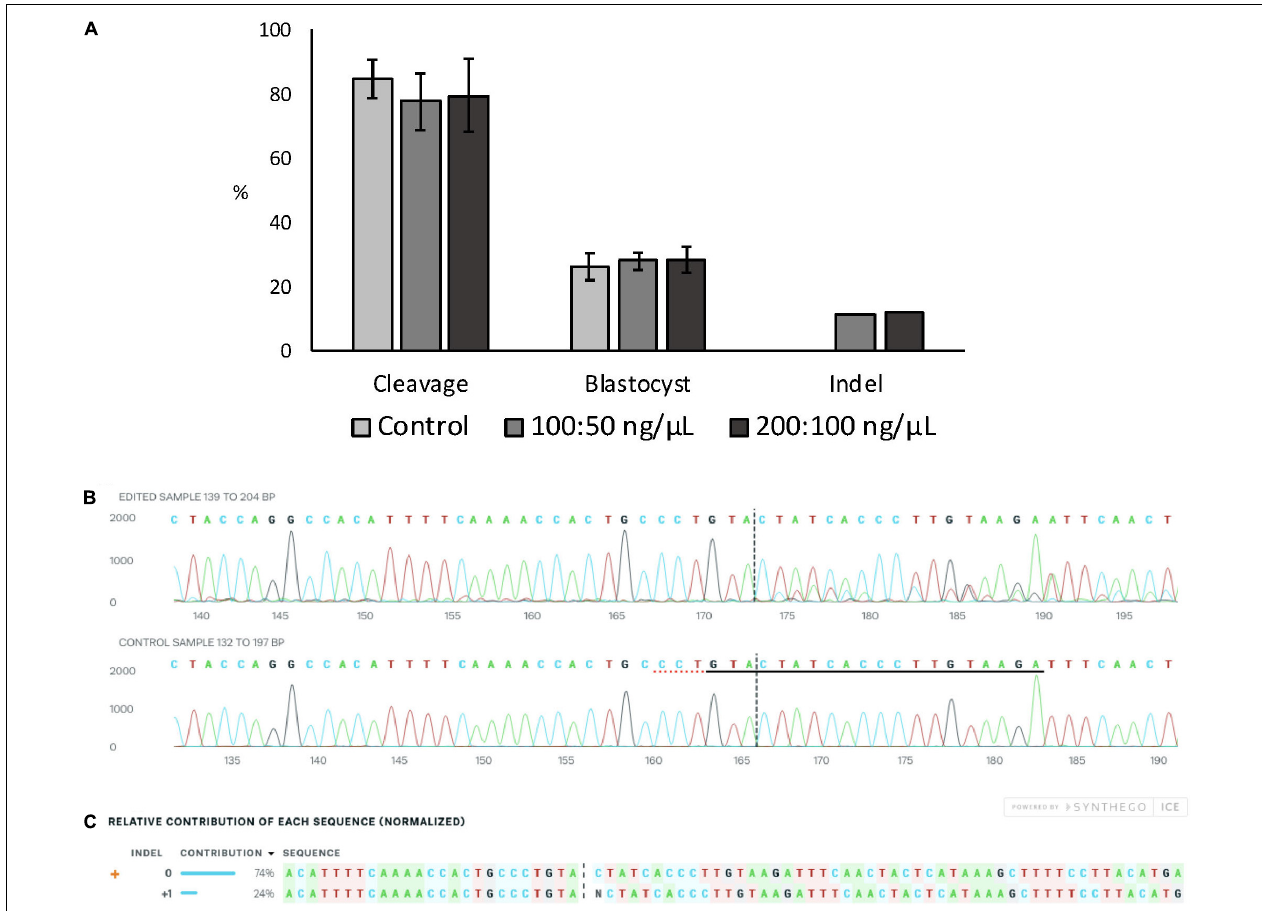
FIGURE 2 | Effect of Cas9:sgRNA concentration on electroporation efficiency of bovine zygotes. (A) Cleavage and blastocyst rates (based on number of presumptive zygotes cultured) and indel rate (based on number of blastocysts sequenced) after electroporation of bovine zygotes with RNPs targeting the ZFX gene. No difference between groups was observed ( P > 0.05). The experiment was replicated three times. Sample size per group: control (no electroporation) = 112 zygotes; 100:50 ng/ µ L = 103 zygotes, and 200:100 ng/ µ L = 101 zygotes. Blastocysts sequenced: 100:50 ng/ µ L = 27; 200:100 ng/ µ L = 25. (B) Trace file provided by ICE software of a representative blastocysts electroporated with 15 V and 200:100 ng/ µ L Cas9:sgRNA. The sgRNA ZFX sequence is underlined in black and the PAM sequence is denoted by a dotted red underline in the control sample. (C) Relative contribution of each sequence identified by ICE in the same representative embryo. The insertion of one nucleotide was derived from one sequence with a contribution of 24%. Expected Cas9 cut site is shown by black vertical dotted lines in (B,C)